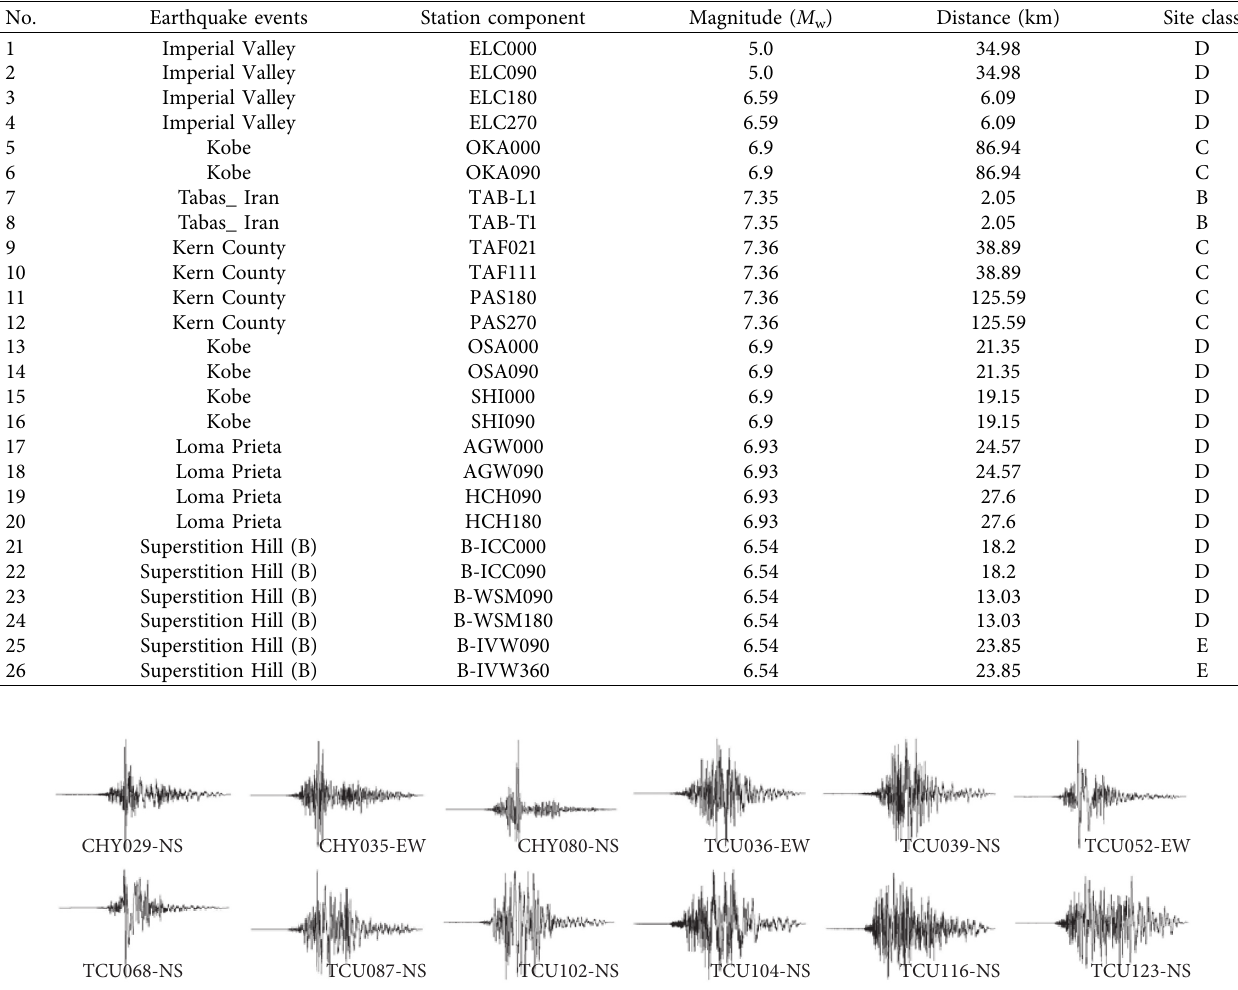
Table 3: Basic information of common earthquake records.